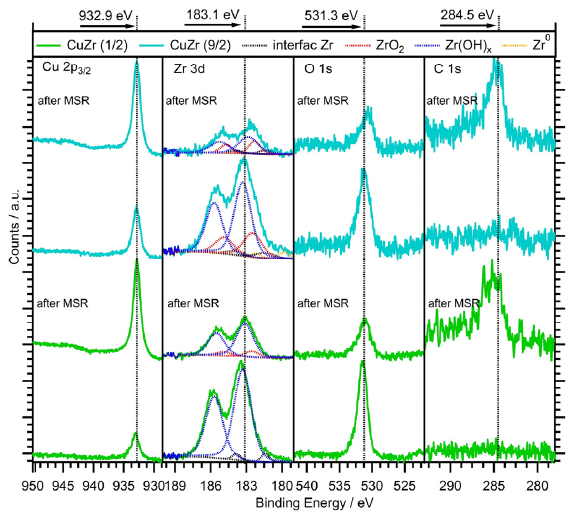
Figure 11. Ex situ collected XP spectra before and after the methanol steam reforming reaction on the Cu ‐ Zr samples with Cu excess (nominal Cu:Zr stoichiometry = 9:2, green traces) and Zr excess (nominal Cu:Zr stoichiometry = 1:2, turquoise traces). The Cu 2p, Zr 3d, O 1s and C 1s signals are shown in separate panels.